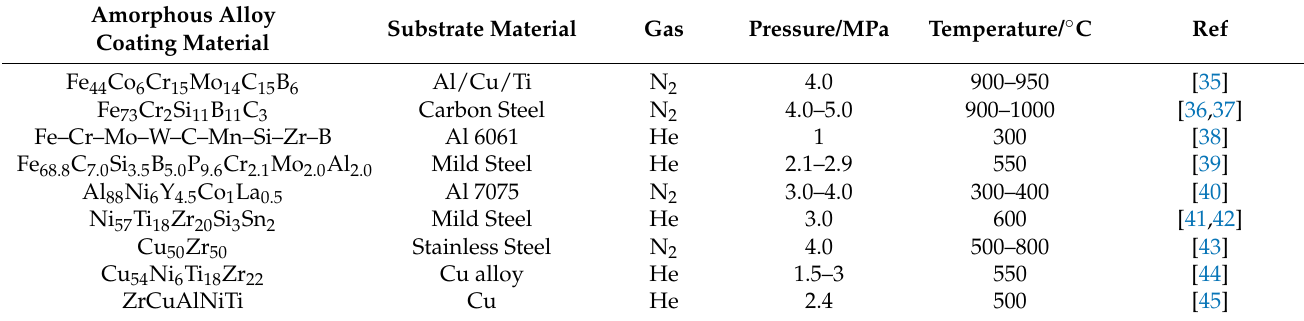
Table 1. Typical types and process parameters of cold spray (CS) amorphous alloy coatings. Amorphous Alloy